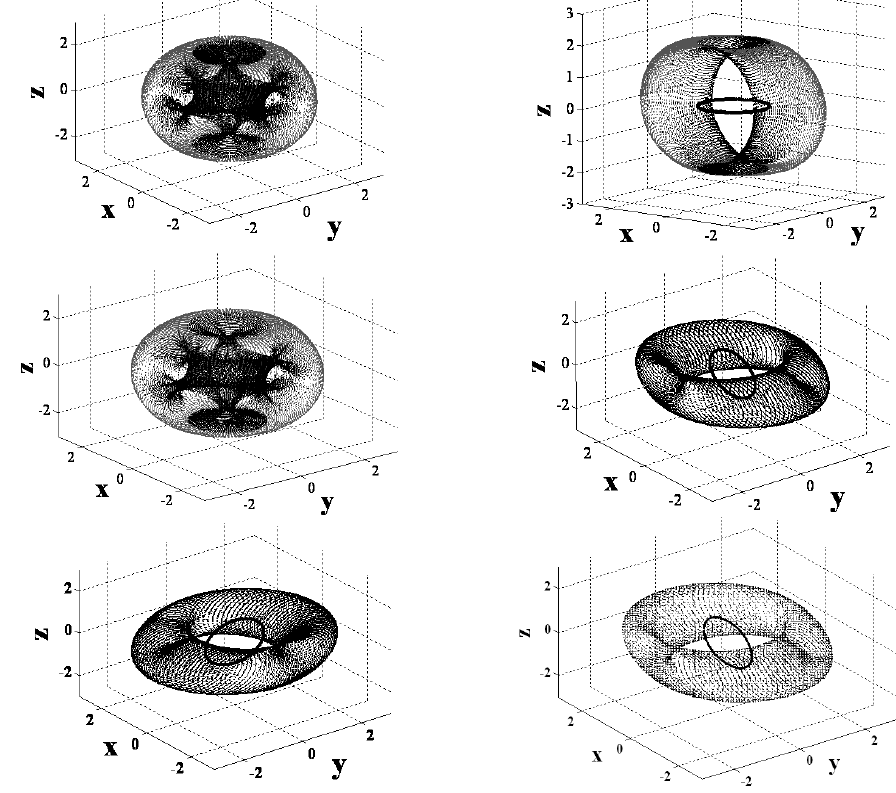
Figure 4. Singular hypersurfaces resulting from 6 possible combinations of mixed skew angles. Singular surfaces from upper left correspond to sequence of mixed skew angles per Figure 3.